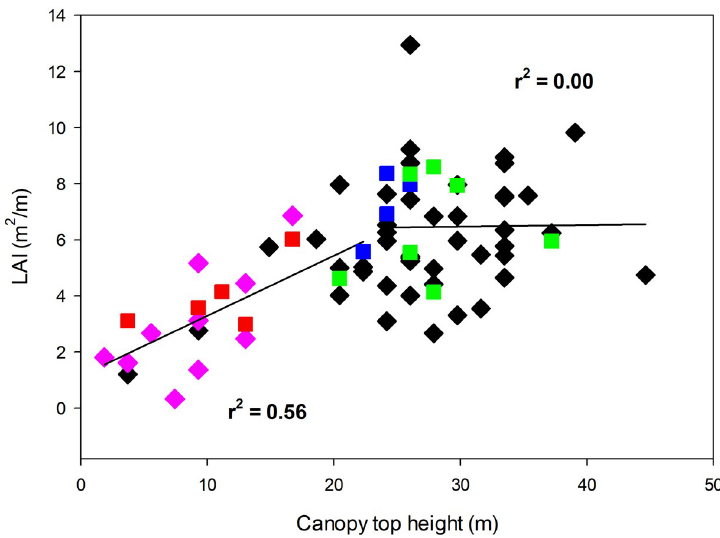
Fig 1. LAI as a function of canopy height across a successional gradient from abandoned pasture to old growth tropical wet forest at La Selva Biological Station, Costa Rica. Data from 18-yr-old secondary forest are shown in red squares, 25-yr-old sites in blue squares, 35 yr-old sites in green squares, black diamonds are 45 random patches in old growth, and pink diamonds are 10 old-growth patches selected for canopy height < 16 m. R 2 were calculated using towers from all sites that met the height criteria (N = 26 < 23 m patch height, 45 > 23 m patch height). Canopy height ranges for the regressions were determined by visual inspection, so no probability values are given. https://doi.org/10.1371/journal.pone.0256571.g001 canopy height and an LAI of approximately 6 (Fig 1). Regardless of stand successional status, leaf area was added in a predictable linear fashion (r 2 = 0.56) with increasing canopy height to ca. 23 m, above which there was no relation (r 2 = 0.00) at this spatial scale (5 m 2 ). There were no significant differences among secondary forest stands in the depth or total LAI of strata and free air spaces (all four ANOVA P > 0.05, Table 2), and there were no differ- ences in these variables between all secondary forest sites combined and all old-growth sites (all four ANOVA P > 0.05). In contrast to the saturating relation of LAI accumulation with for- est height, the number of secondary-forest canopy strata increased as canopy height increased (r 2 = 0.48, P < 0.002, N = 16, S2 Fig). The relation of the number of strata to canopy height 1-tail was not significantly different between all 55 old-growth sites and all 16 secondary sites (ANCOVA P > 0.33). For all secondary and old-growth sites combined (Fig 2), the number of